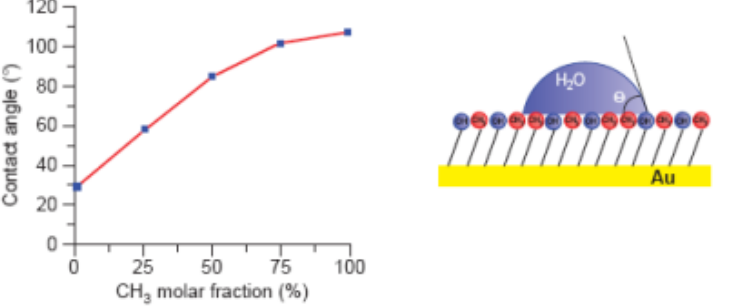
Force vs. distance curves (or force vs. displacement vertical curves) are used to collect